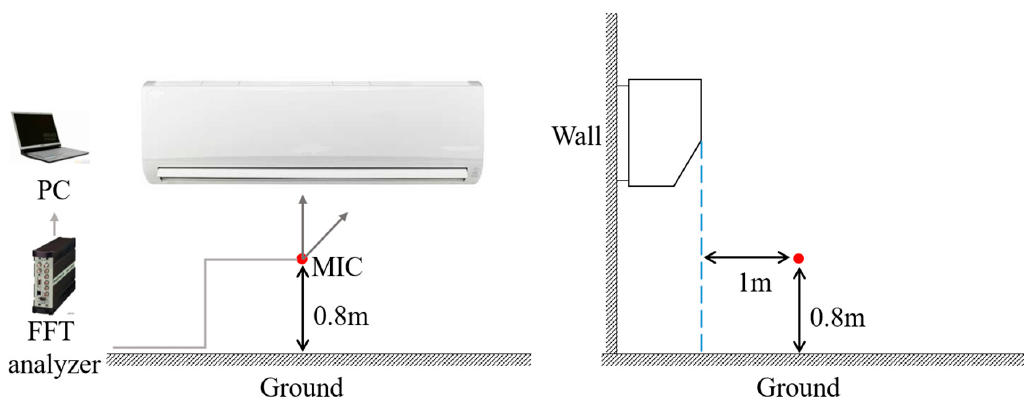
Figure 1. Experimental setup.